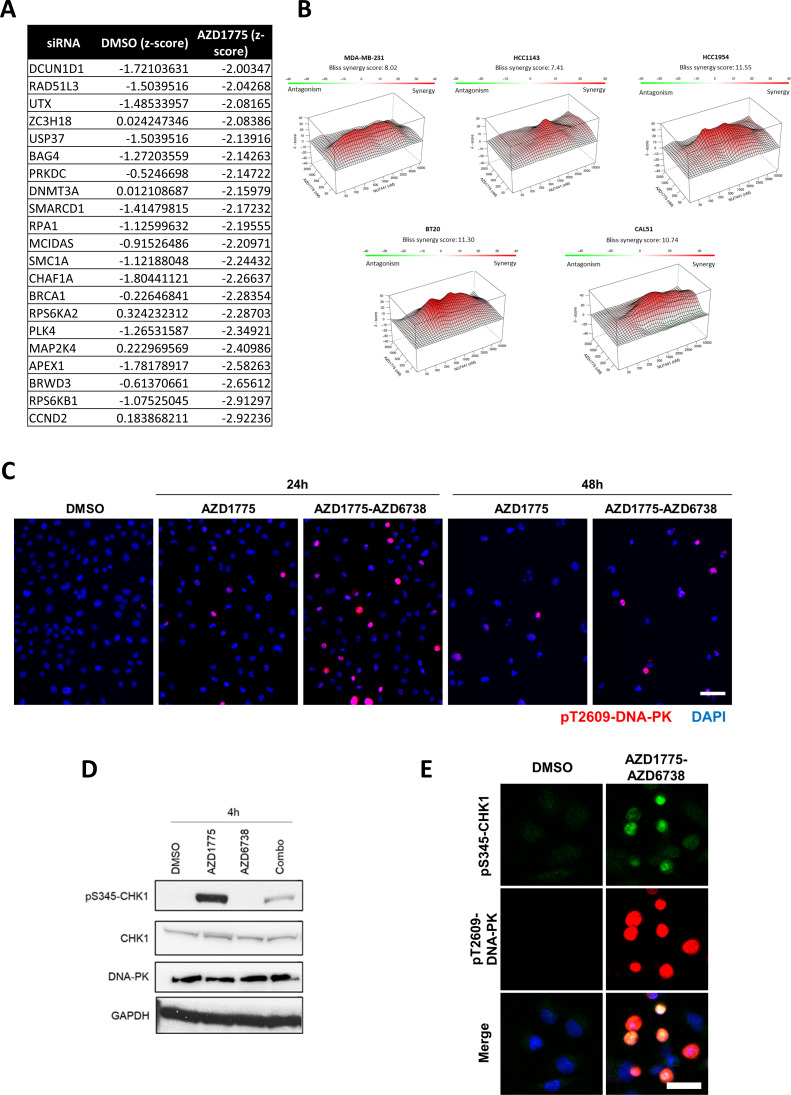
DNA-PK is phosphorylated in response to AZD1775 and preserves CHK1 phosphorylation independent of ATR.(A) List of genes whose siRNA-mediated knockdown selectively reduced viability of AZD1775-treated MDA-MB-231 cells in the high-content siRNA screen (Figure 4A). z-scores in DMSO and AZD1775-treated conditions are specified (negative values indicating reduced viability). (B) BLBC cell lines were treated with the indicated compounds at different concentrations for three days. Drug synergies from dose-response matrices are shown as surface plots to visualize interaction at different drug concentrations. Plots were generated and synergy scores calculated based on the Bliss model using the publicly-available online tool SynergyFinder (Ianevski et al., 2017). (C) Representative immunofluorescence images for staining of pT2609-DNAPK (red) in MDA-MB-231 cells treated with the AZD1775 or the AZD1775-AZD6738 combination or DMSO for 24 hr and 48 hr. Scale bar = 60 μm. (D) MDA-MB-231 cells were treated as indicated for 4 hr and total cell lysates were immunoblotted with the indicated antibodies. (E) Representative immunofluorescence images for staining of pS345-CHK1 (green) and pT2609-DNA-PK (red) in MDA-MB-231 cells treated with AZD1775, AZD6738, AZD1775-AZD6738 combination or DMSO for 24 hr. Scale bar = 30 μm.